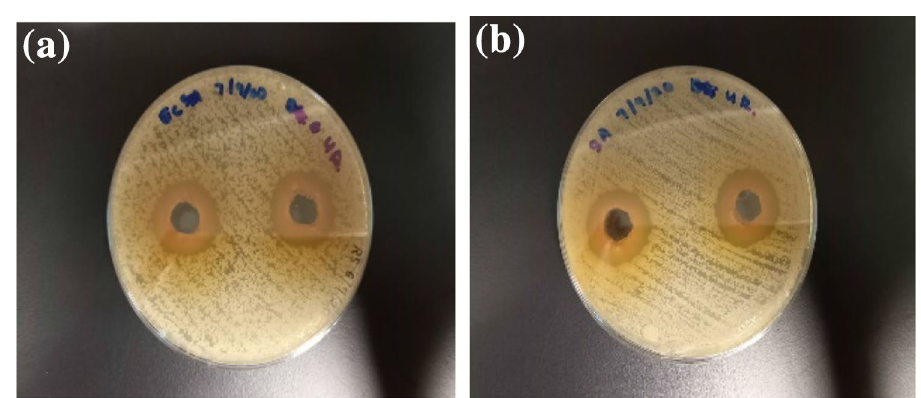
Figure 3. Inhibition zone of C. caudatus extract on ( a ) E. coli , ( b ) S.